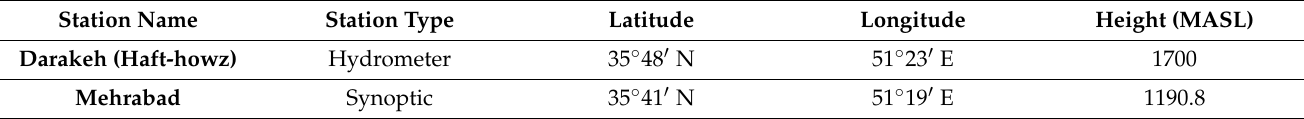
Table 2. The characteristics of two main stations in the basin for rainfall data